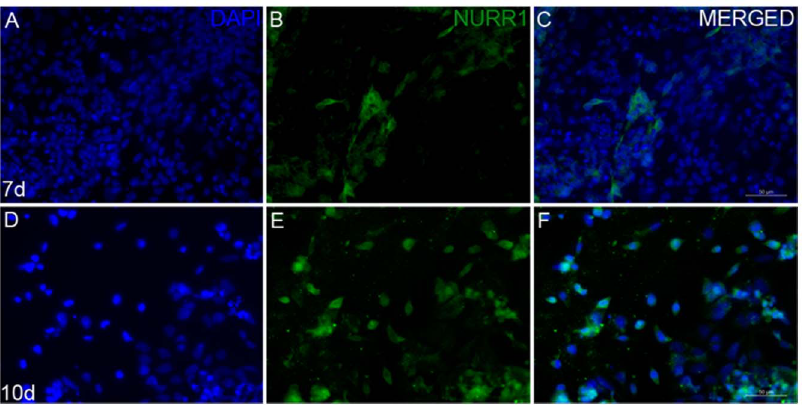
Figure 4. Expression of NURR1 in 7 and 10 days differentiated cells. Immunocytochemistry showing the levels of NURR1 proteins as a midbrain dopaminergic neuronal marker in 7days (A–C) and 10 days (D–F) differentiated cells. DAPI stained the nuclei (A,D). Scale bar is 50 m m.